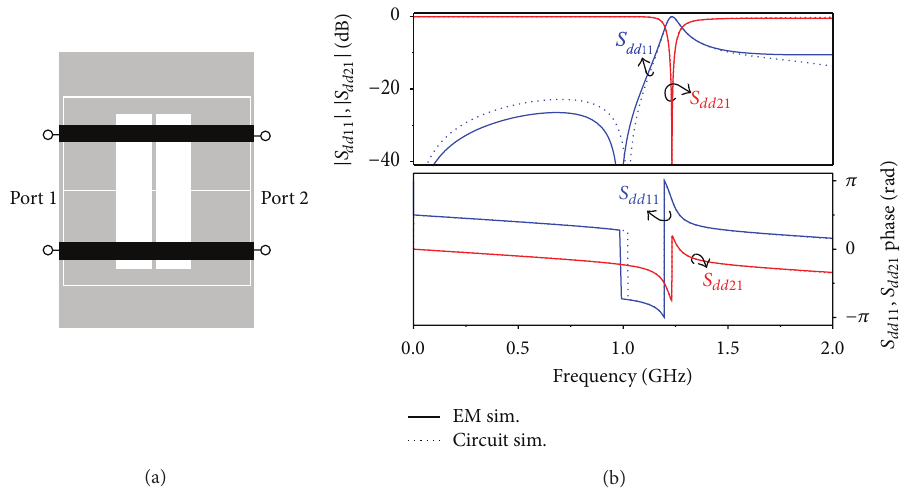
Figure 7: Layout (a) and differential mode frequency response (b) for a differential microstrip line loaded with an MLC with the electric wall aligned with the line and for its circuit model of Figure 6. The dimensions and the substrate are the same as those given in the caption of Figure 5, except for 𝑙 1 = 2 mm and 𝑤 1 = 8 mm. The circuit parameters are 𝐿 = 6.07 nH, 𝐶 = 1.53 pF, 4 𝐶 𝑚 + 𝐶 𝑔 /2 = 7.47 pF (where for dimensions 𝐶 𝑔 ≈ 14 𝐶 𝑚 ), and 𝐿 𝑚 = 3.71 nH.